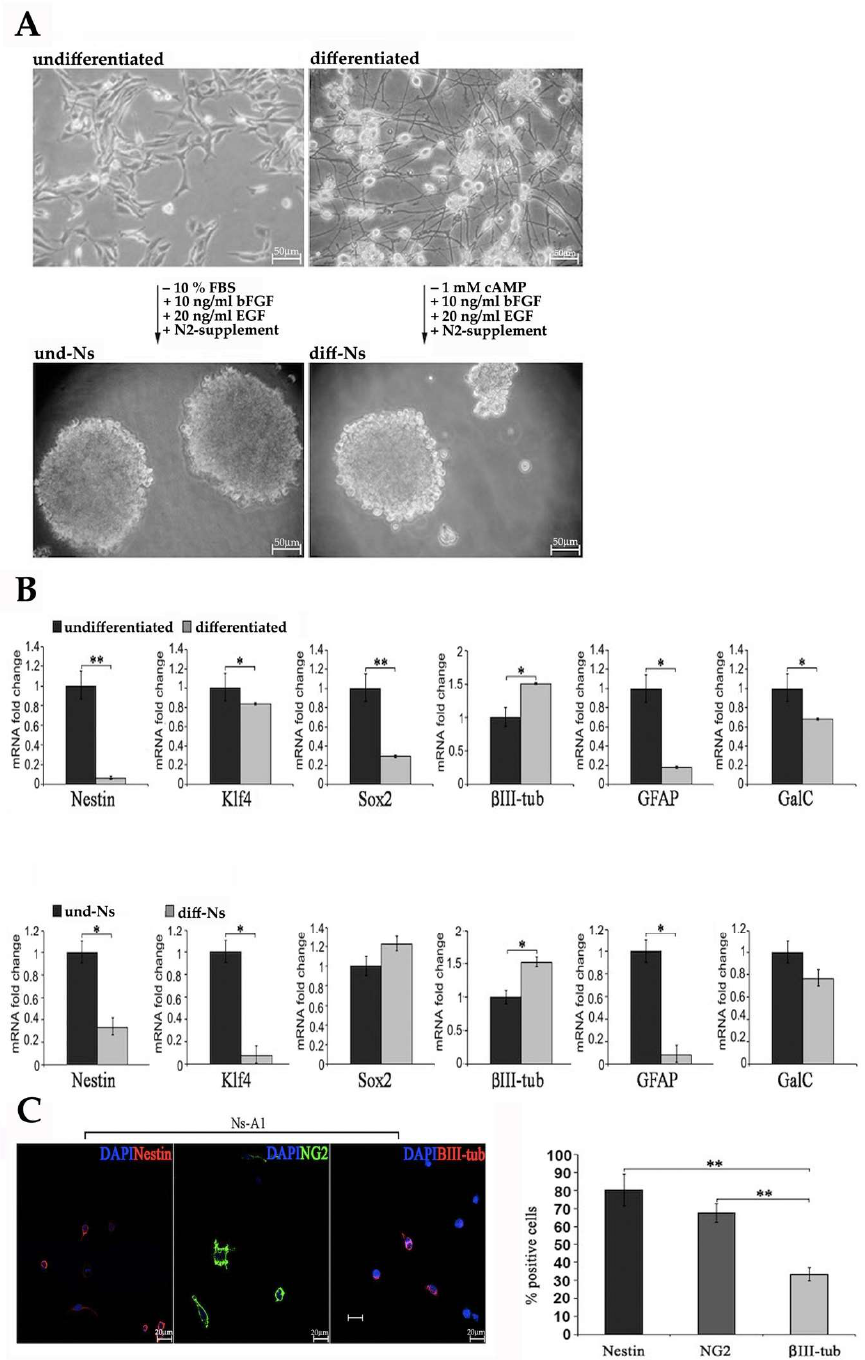
Figure 1. Expression of staminal and neural markers by und-Ns and diff-Ns. ( A ) (upper panel) Undifferentiated (und) and differentiated (diff) A1 cells deprived of FBS and cAMP, respectively and cultured in a medium supplemented with bFGF, EGF and N2 form (black arrows) neurospheres (Ns): und-Ns and diff-Ns, respectively (lower panel). Scale bar = 50 µ m. ( B ) Expression of the staminal markers Nestin, Klf4 and Sox2 and neural markers β III-tubulin, GFAP and GalC, investigated by real-time PCR in undifferentiated and differentiated A1 cells (upper panel), und-Ns and diff-Ns (lower panel). Data expressed as mRNA fold changes with respect to und (upper panel) or und-Ns A1(lower panel) are reported as mean ± S.D. ** p < 0.01 und versus diff A1 cells; * p < 0.05 und versus diff A1 cells; * p < 0.05 und-Ns versus diff-Ns. ( C ) Immunofluores- cence analysis of Nestin (red), NG2 (green), β III-tub (red) and DAPI nuclei (blue) in neurosphere-derived A1 (Ns-A1) cells cultured in presence of mitogenic factors for 24 h (day 0). Scale bar = 20 µ m. The percentage of positive cells was calculated by counting the number of Nestin-, NG2- and β III-tubulin-positive cells as a proportion of blue DAPI positive